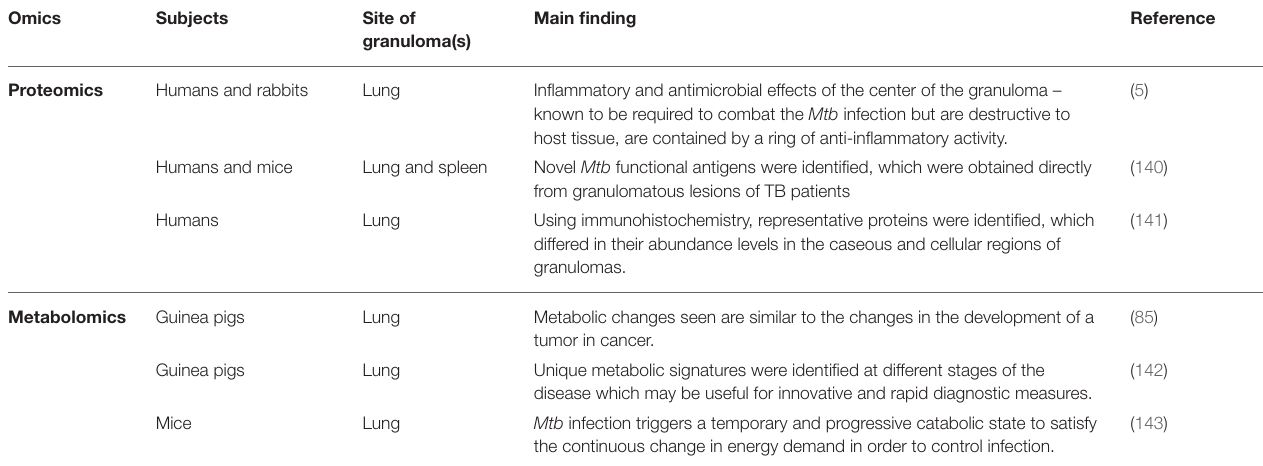
TABLE 2 | Main findings from studies describing the role of proteomes and metabolomes in granulomas in both animal and human subjects infected with Mtb .